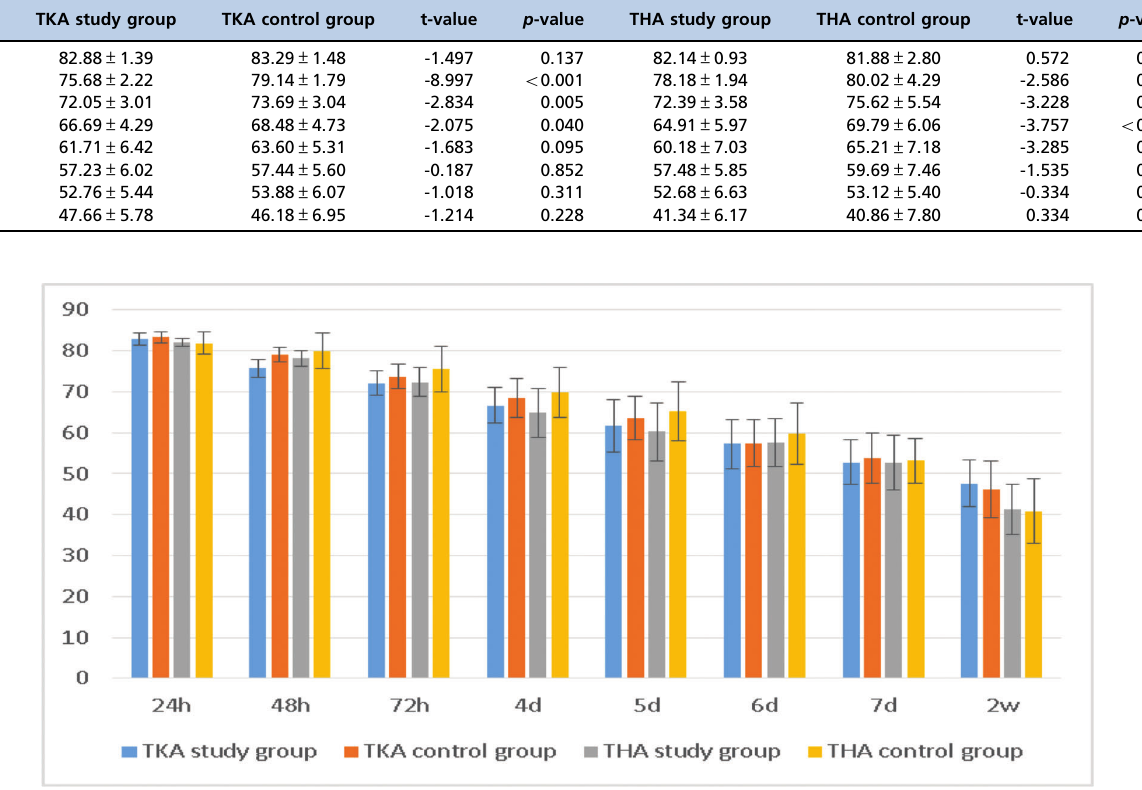
Figure 6 - WOMAC scores after the